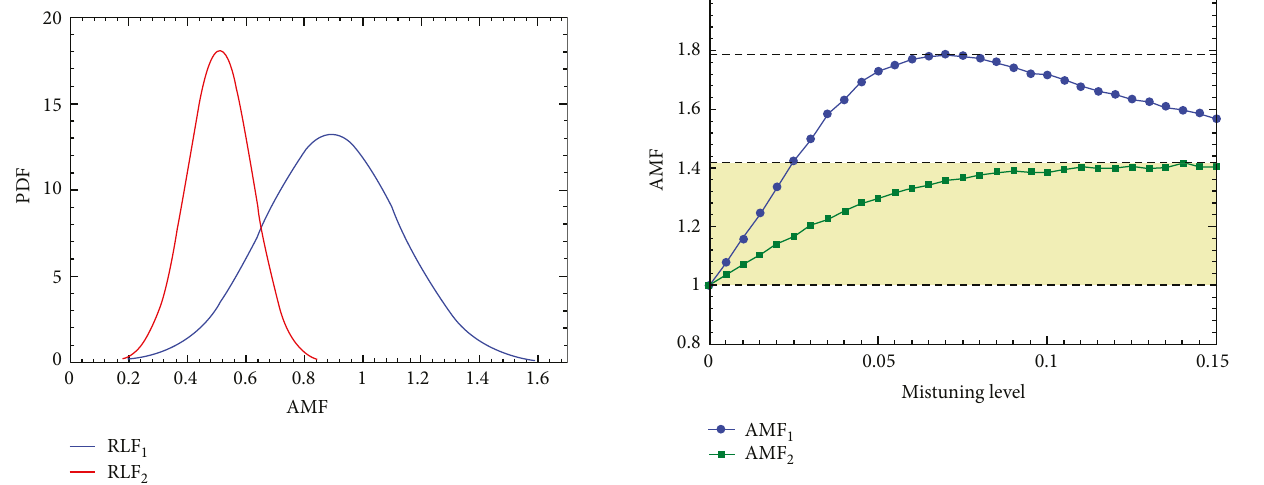
Figure 14: Probability density function of RLF ( E = 2 , △ γ